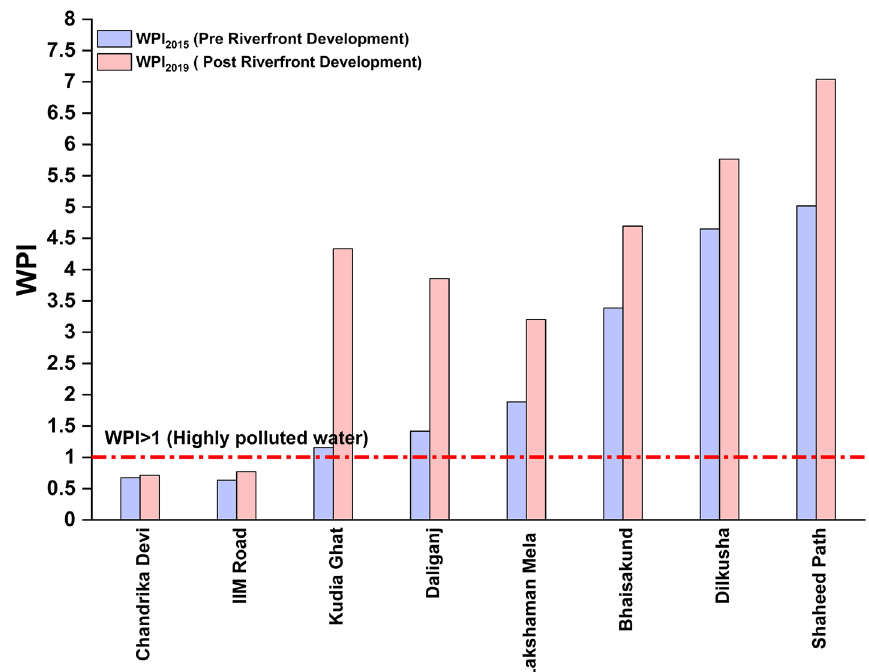
Fig. 2 Variation of WQI in pre- riverfront and post-riverfront